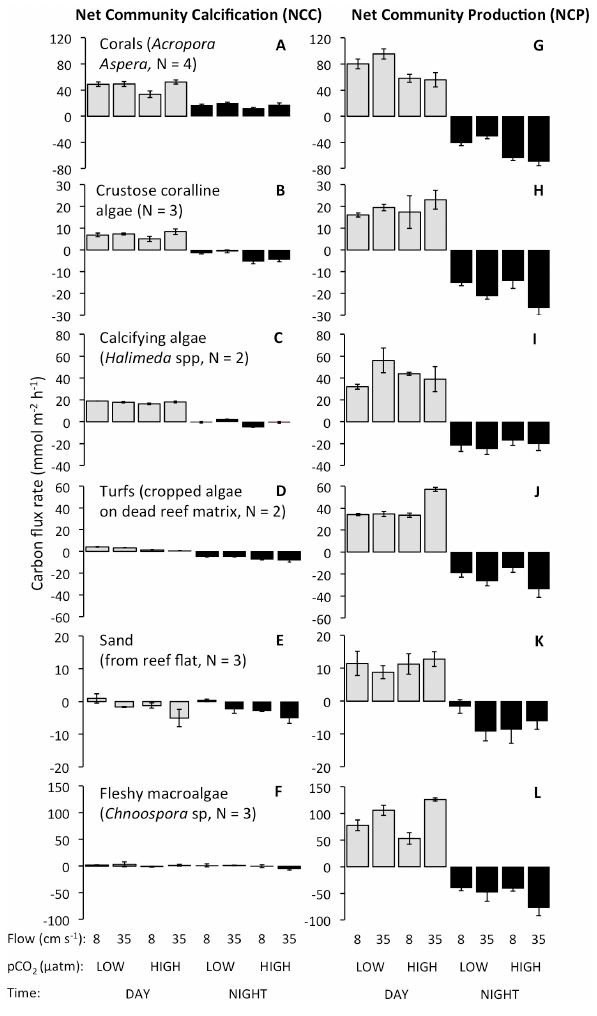
Fig. 5. Net rates of community calcification (left panels) and pro- duction (right panels) at high light (day, grey columns) and in dark- ness (night, black columns) under varying flow velocities (8 and 35cms − 1 ) and p CO 2 regimes (Low=350–450µatm, High=560– 700µatm). Data are means ± SE of N =2 to 4 replicate communi- ties. Note different scales on y